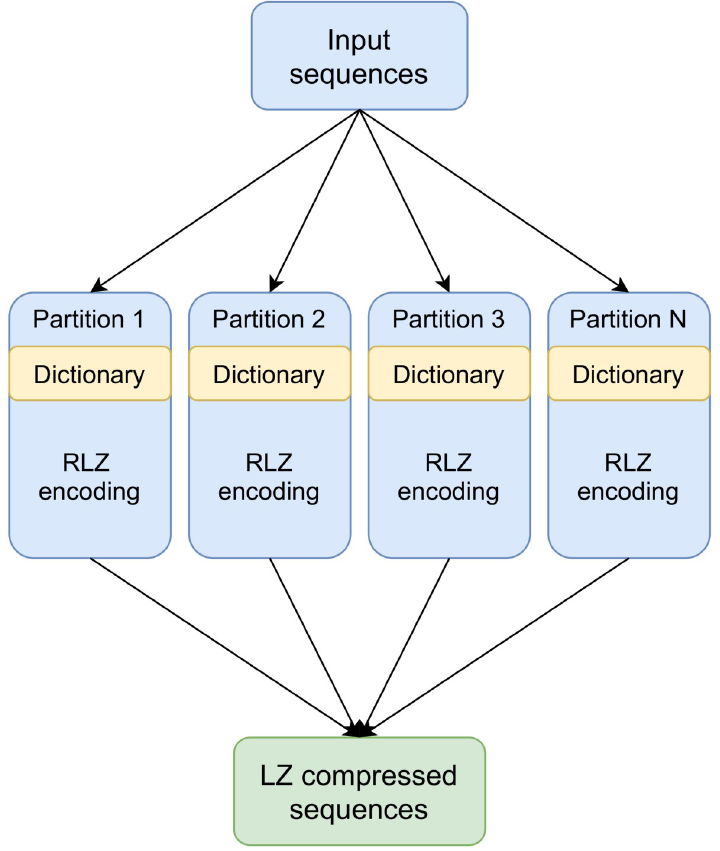
Fig 1. Distributed Relative Lempel-Ziv